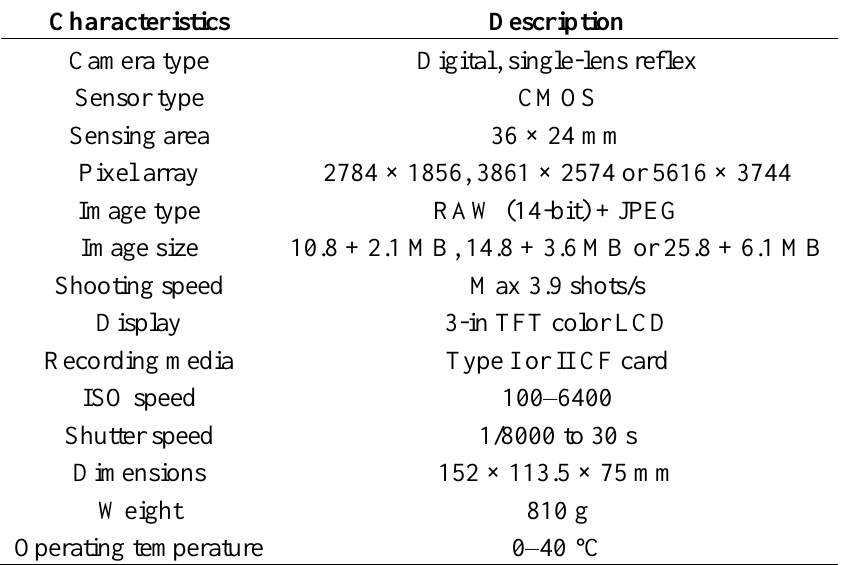
Table 1. Major specifications of a Canon EOS 5D Mark II